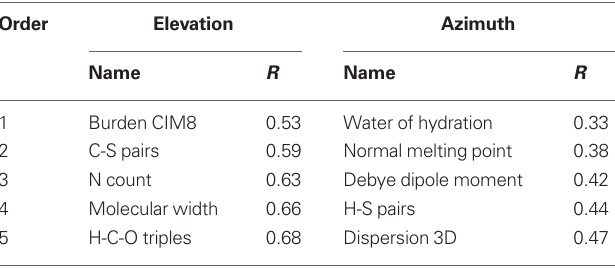
Table 1 | Physico-chemical and structural properties of odorant molecules that contribute most strongly to the two perceptual